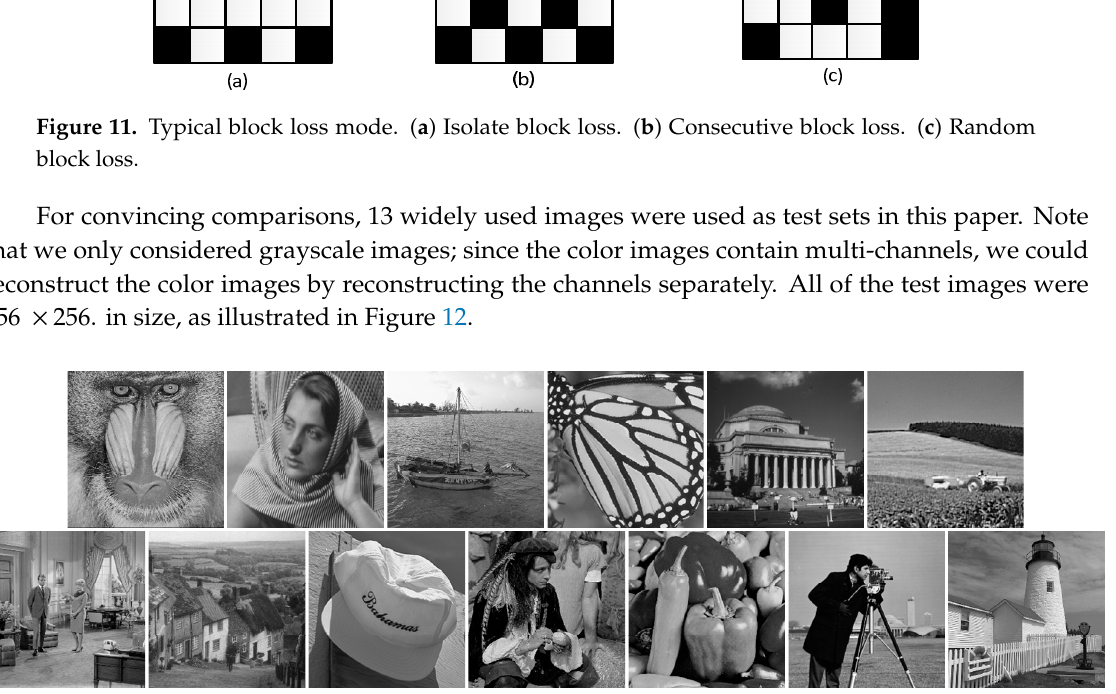
Figure 12. The 13 test images used in our experiments. From left to right and top to bottom: Baboon, Barbara, Boat, Butterfly, Columbia, Cornfield, Couple, Goldhill, Hat, Man, Peppers, Tower.